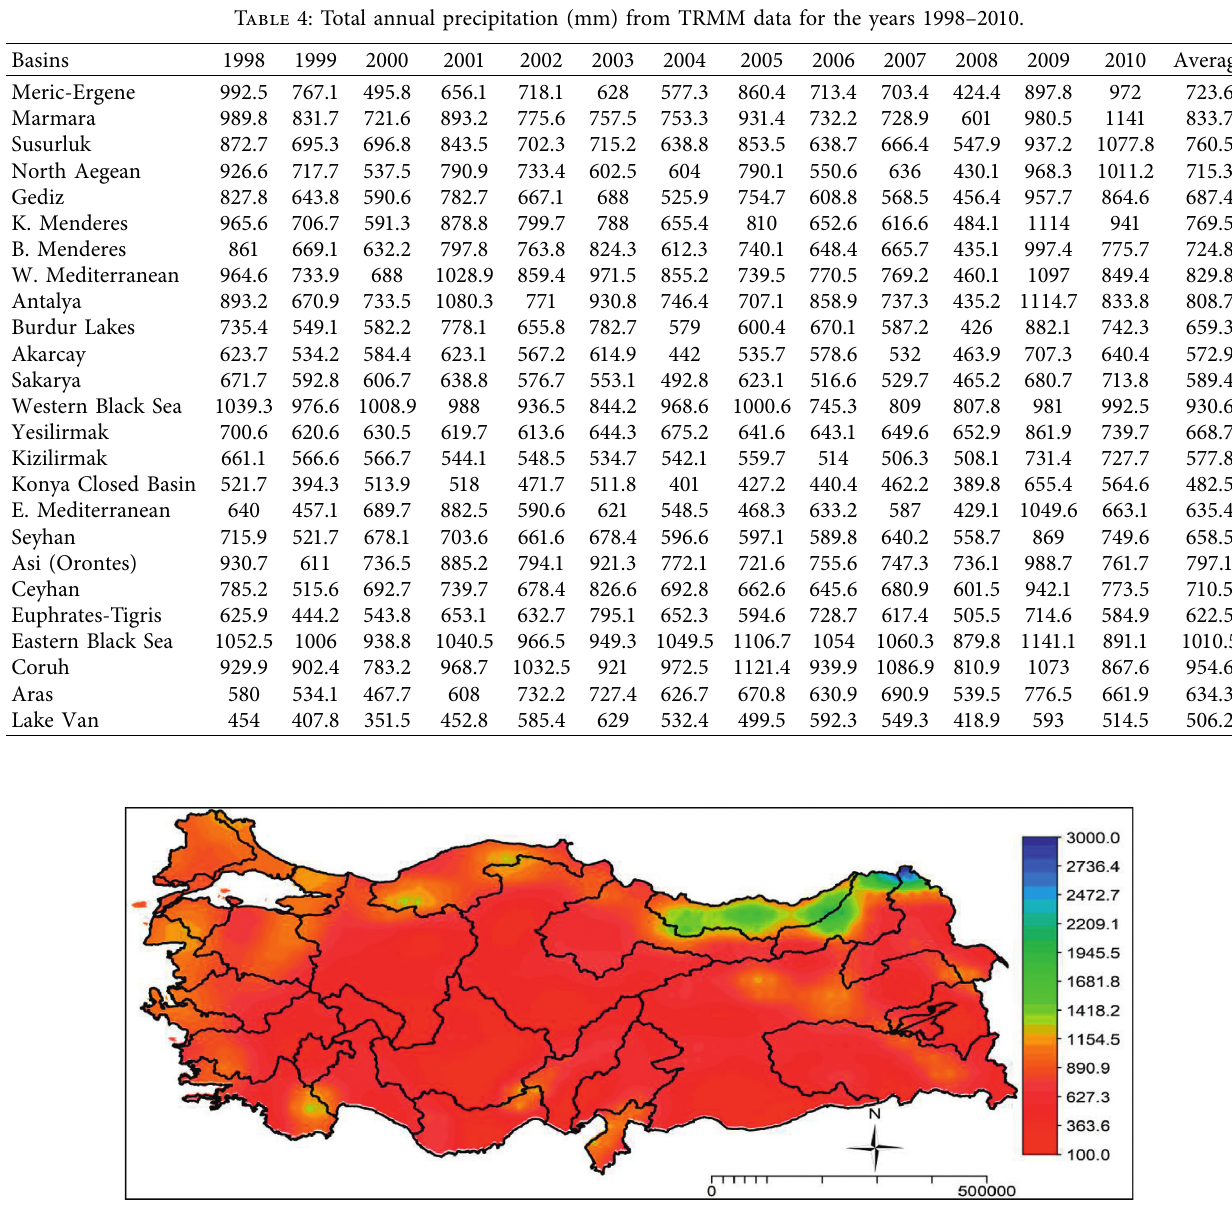
Figure 4: Areal annual precipitation distribution map for Turkey for